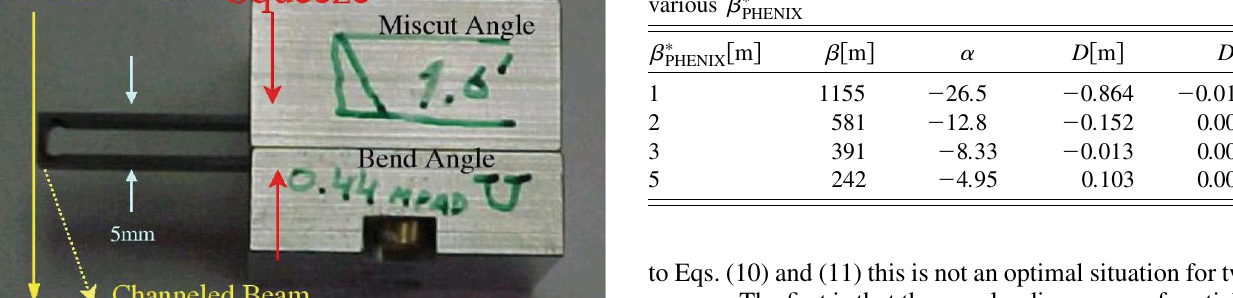
FIG. 7. (Color) Model horizontal (cid:8) functions and dispersion function near the crystal collimator for (cid:8) (cid:10)